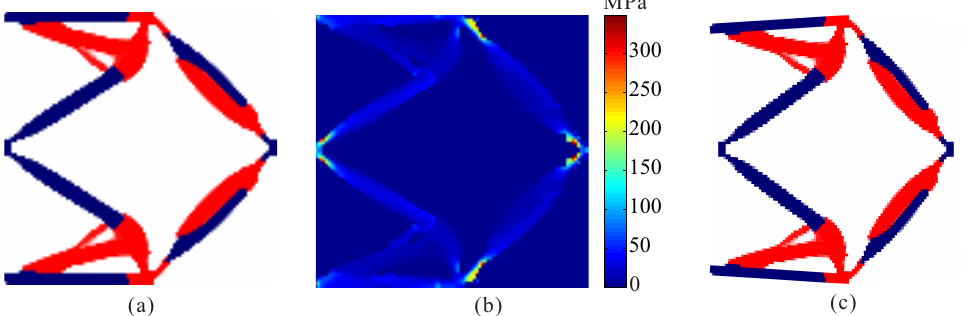
Figure 3. The results for topological design of multi-material compliant inverter with stress constraints ( σ ∗ = 275 MPa, σ ∗ = 350 1 2